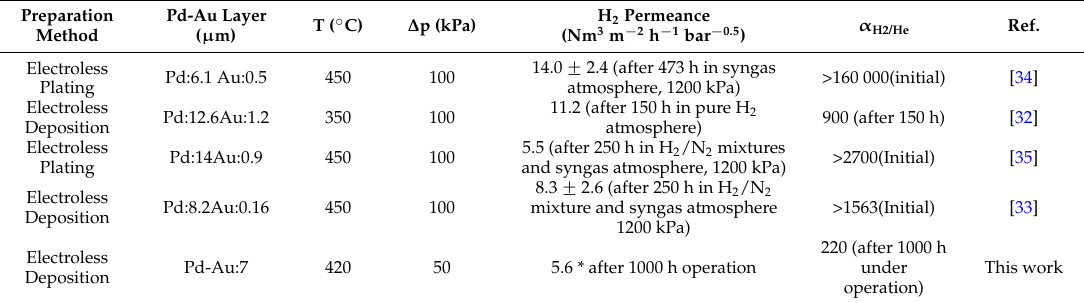
Table 3. A comparison between the long term characteristics of different Pd-Au membranes Preparation